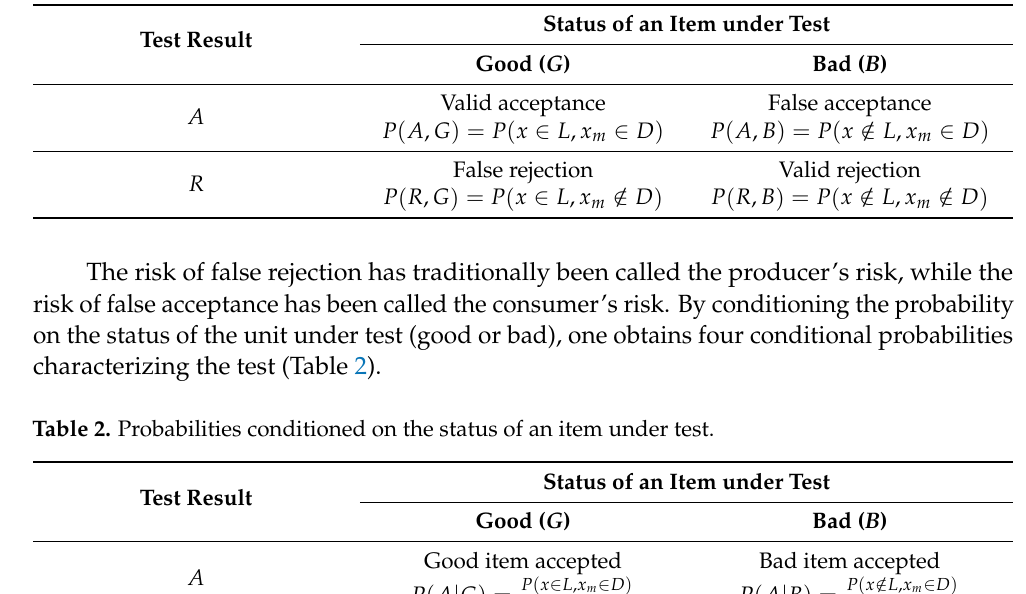
Table 1. Joint probabilities characterizing the binary decision process.